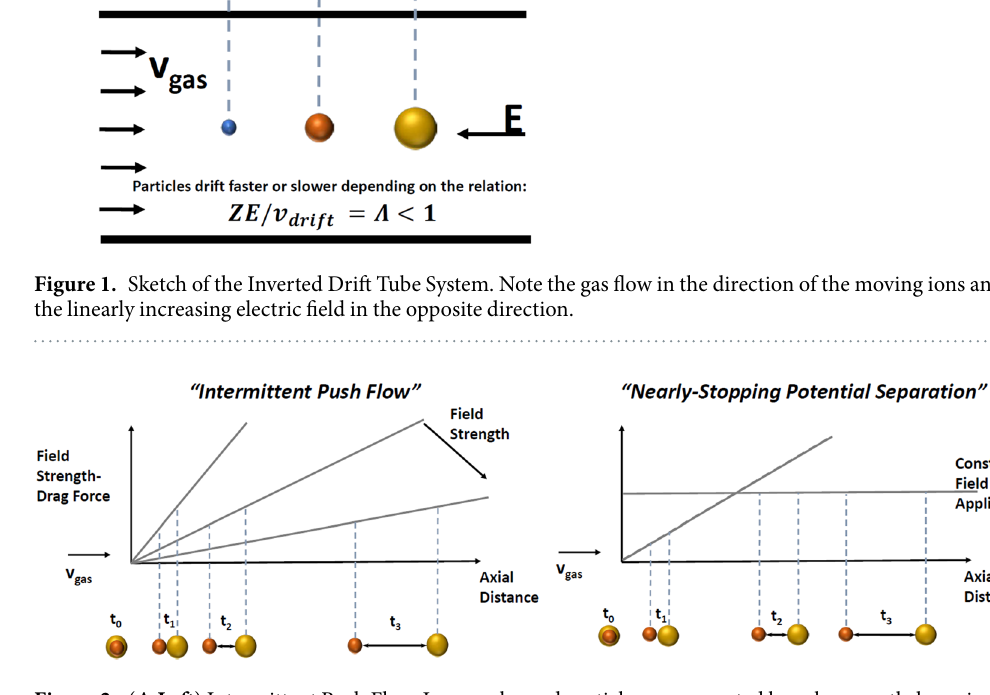
Figure 2. ( A,Left ) Intermittent Push Flow. Ions or charged particles are separated by subsequently lowering a linearly increasing field opposite to the flow. ( B,Right ) Nearly-Stopping Potential Separation. An opposite constant field with separation ratio below 1 is used to maximally separate two relatively close